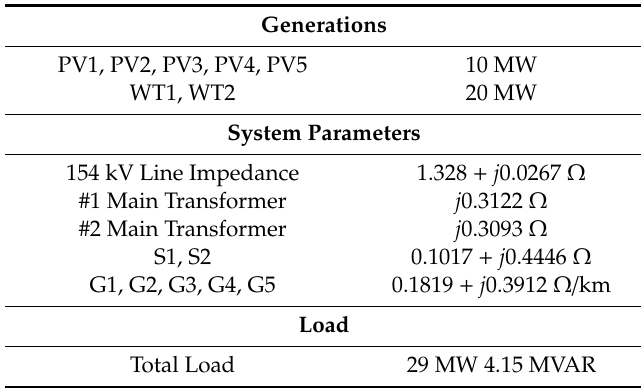
Table 2. Generations, system parameters, and load of “Y” substation.